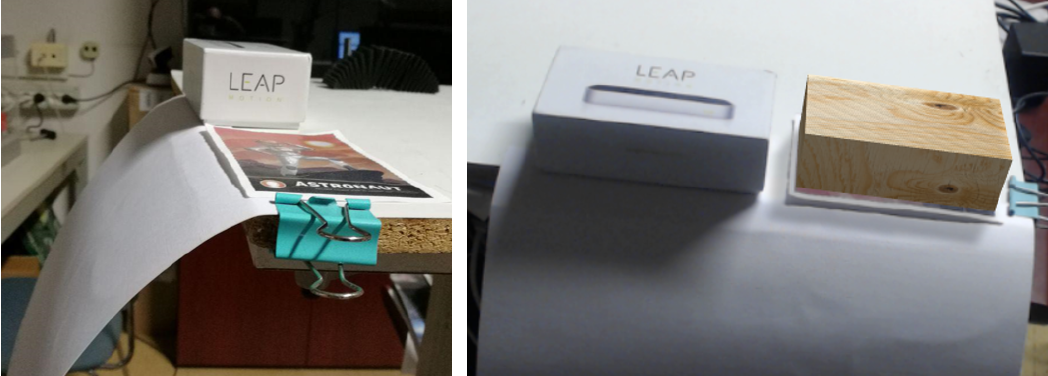
Figure 27. Comparison between real and virtual shadows on a non-planar surface.